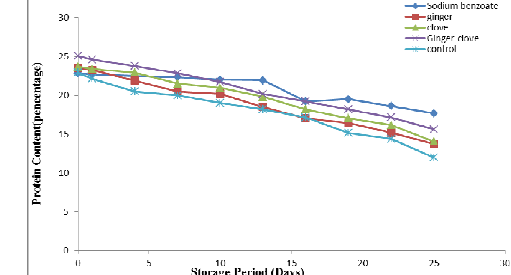
Fig. 11. Effects of different treatments on the protein content of soymilk samples at 3% concentration stored at refrigerated temperature for 25 days